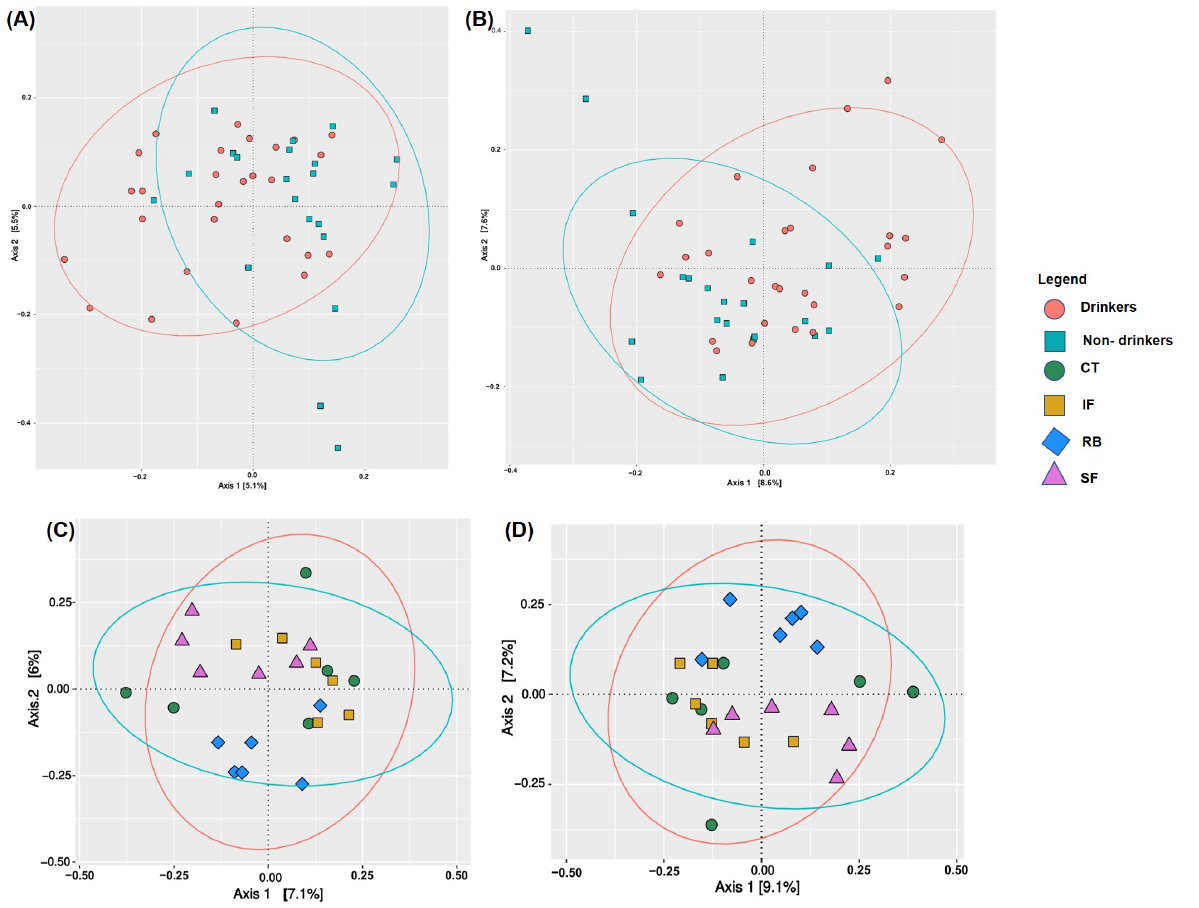
Figure 3. Principal coordinate analyses (PCoA) based on beta diversity indices. ( A , C ) Jaccard and ( B , D ) Bray–Curtis distances demonstrating the microbial communities in human and mice fecal samples,